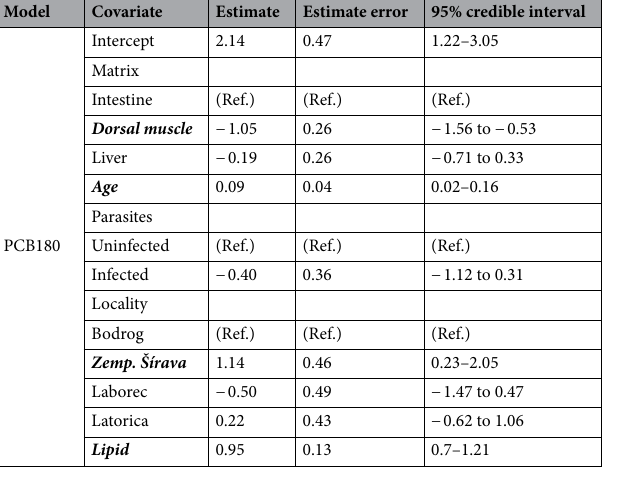
Table 2. Generalized linear mixed models analysing the effects of individual traits (age, lipid content, matrices, parasite infection, locality) on the PCB concentrations. The covariates levels with credible intervals that do not overlap with zero and, therefore, can be considered meaningful predictors are highlighted in bold and italics.